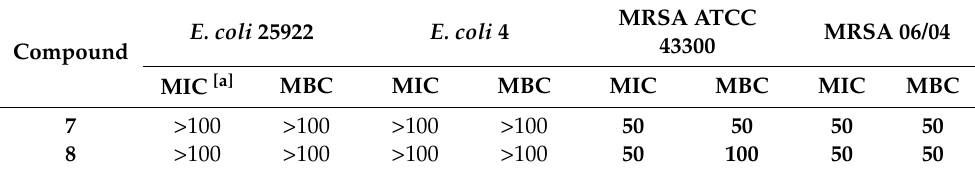
Table 2. The MIC and MBC measurements for compounds 7 and 8